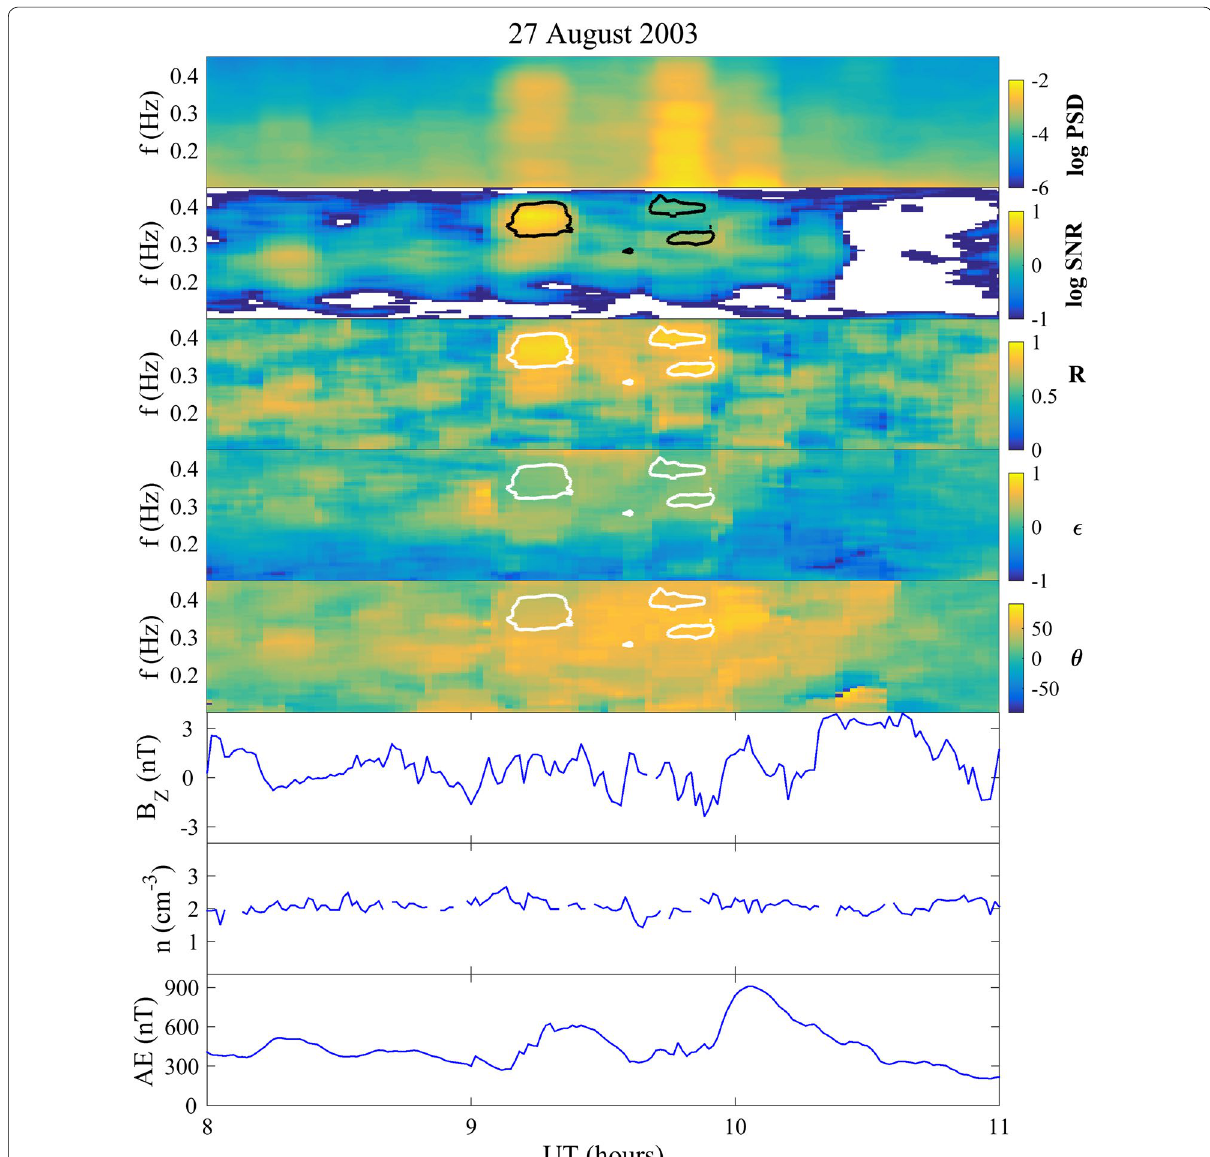
Fig. 14 Midnight case study. The dynamical power spectrum, signal-to-noise ratio, polarization ratio, ellipticity, azimuthal angle, IMF B z component, SW density, and AE index during the August 27, 2003, event. Black and white contours encircle values corresponding to a polarization ratio R >